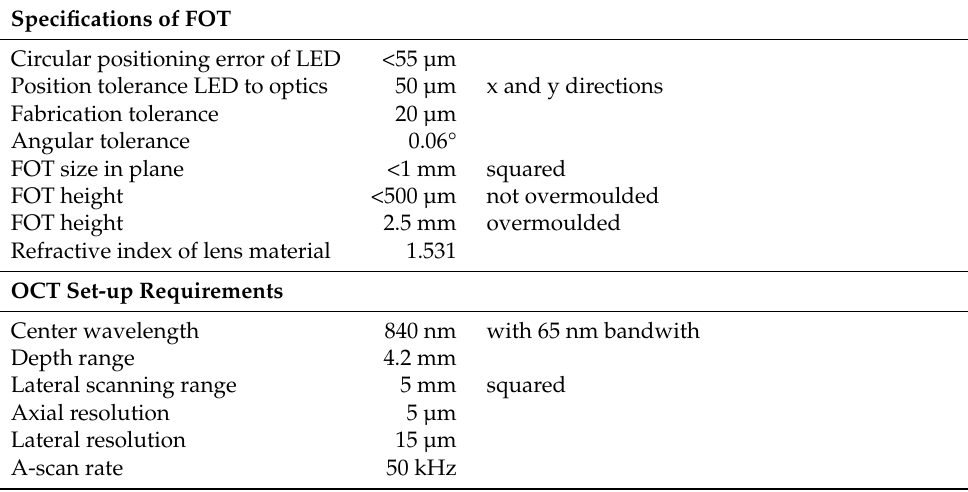
Figure 1. Displacement correction of optoelectronic element with regard to the overmoulded optical element. ( a ) In-plane displacement and two translational and one rotational dimensions. ( b ) Opto- electronic element after displacement correction. ( c ) Part after overmoulding. Table 1. Requirements for FOT position measurement and specifications of OCT